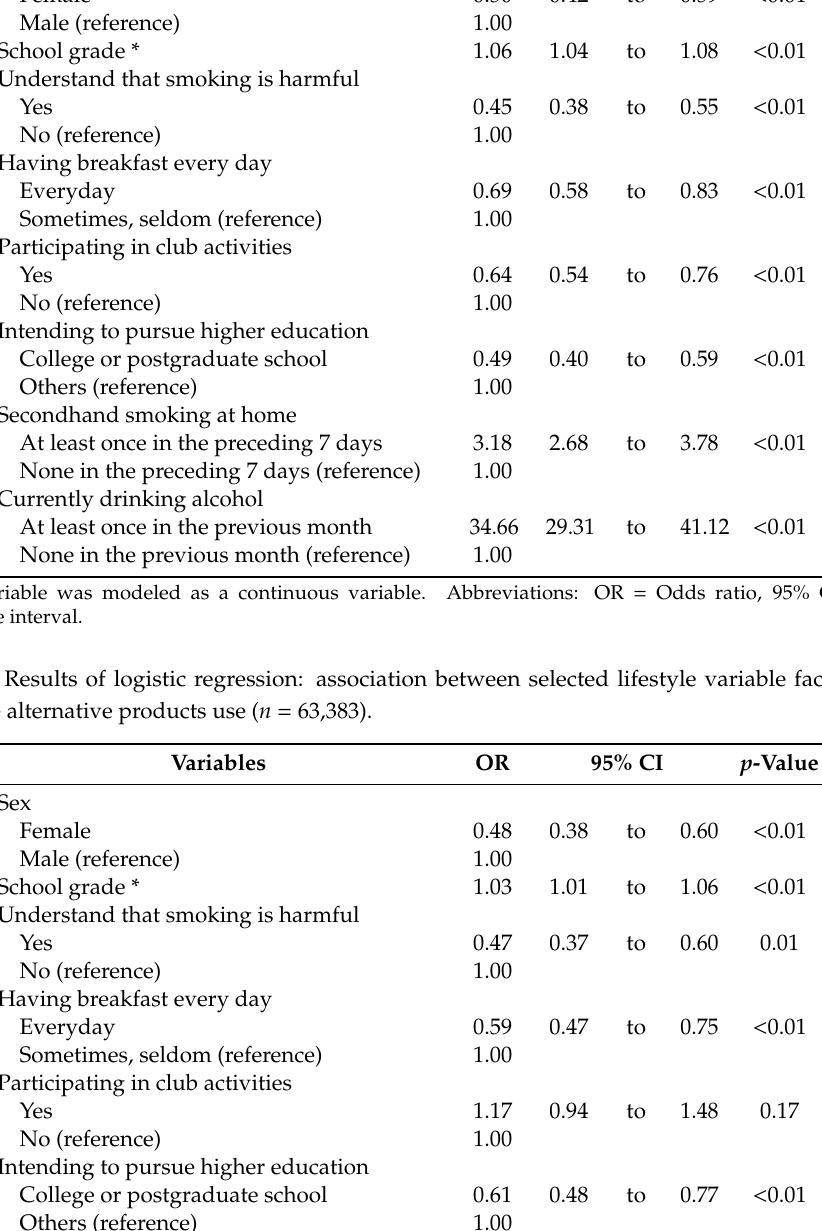
Table 3. Results of logistic regression: association between selected factors and any conventional cigarette smokers ( n = 63,738).